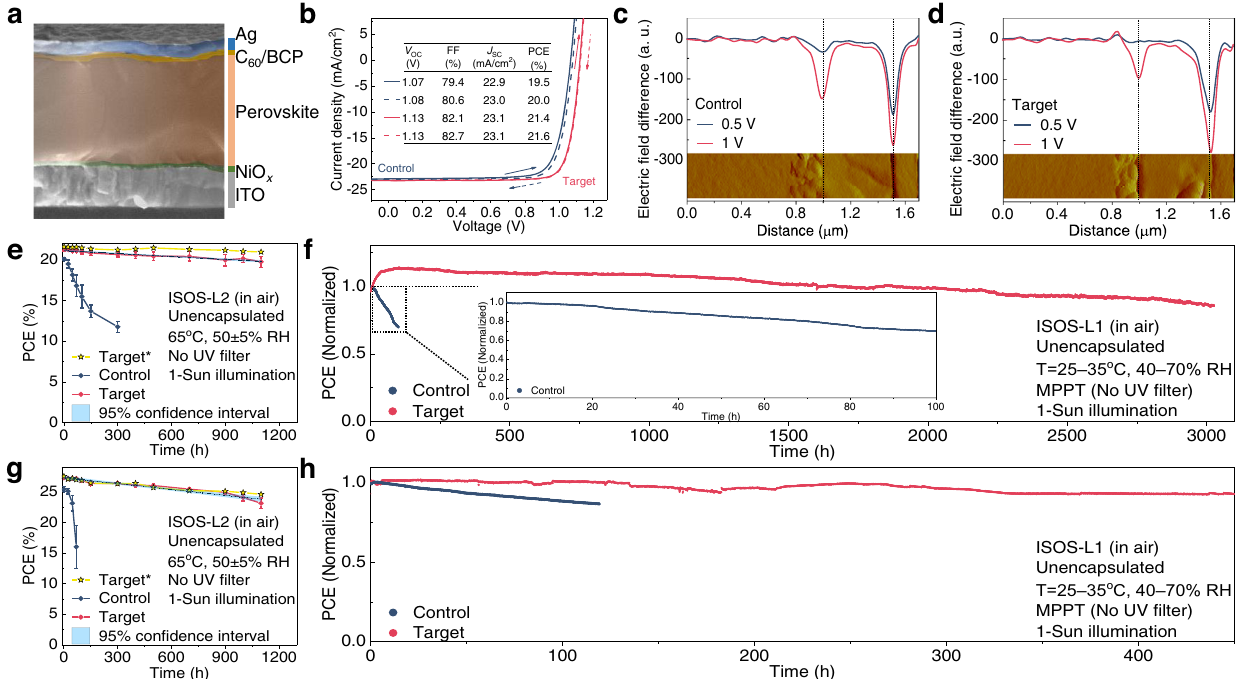
devicesinthesamebatch.The95%con fi denceintervalforthestabilityofthetarget devices is shown as a blue band. f The operational stability of the unencapsulated control and target single-junction devices under MPPT in air. g ISOS-L2 measure- ments of unencapsulated tandem devices. The target champion tandem cell (denoted with*) is indicated with yellow stars (surrounded by black border lines). Standard deviationiscalculated from sixindividualdevices in the same batch. The 95%con fi denceinterval for the stability of the target tandem devices isshown asa blueband. h